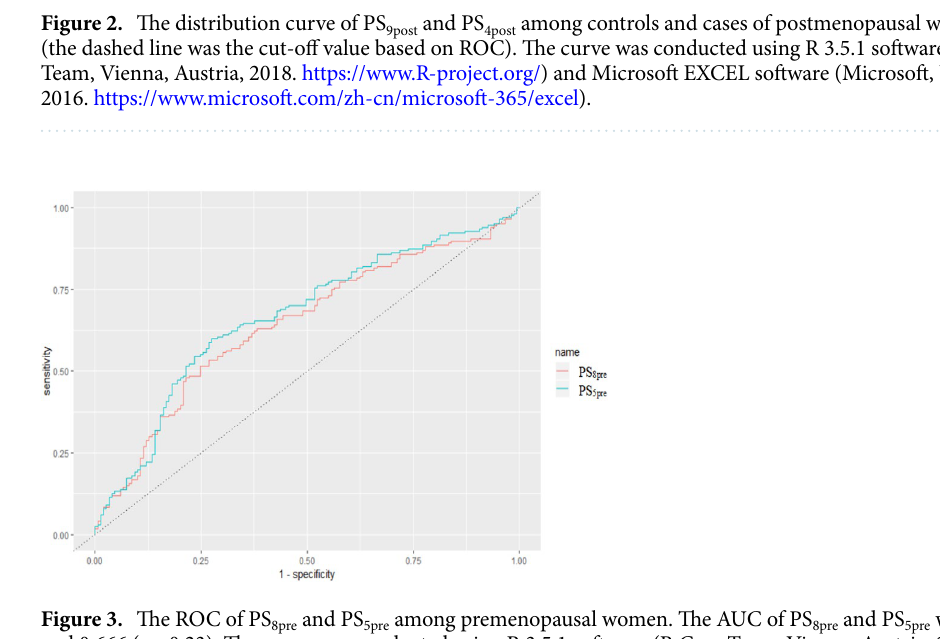
Figure 3. The ROC of PS 8pre and PS 5pre among premenopausal women. The AUC of PS 8pre and PS 5pre were 0.641 and 0.666 ( p = 0.23). The curve was conducted using R 3.5.1 software (R Core Team, Vienna, Austria, 2018. https:// www.R- proje ct. org/) and Microsoft EXCEL software (Microsoft, USA, 2016. https:// www. micro soft. com/ zh- cn/ micro soft- 365/